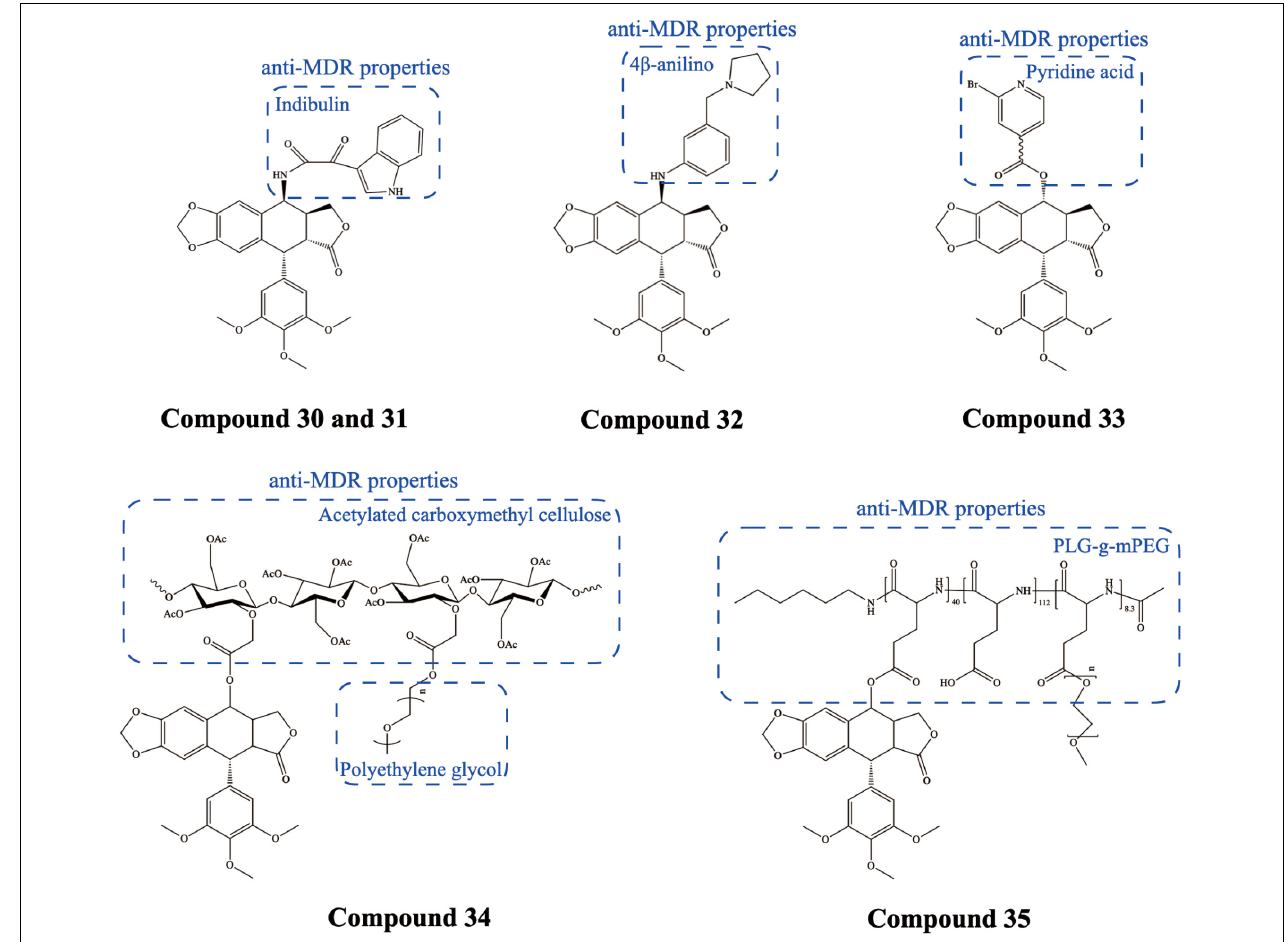
FIGURE 9 | Chemical structures and therapeutic highlights of PTOX derivatives Compound